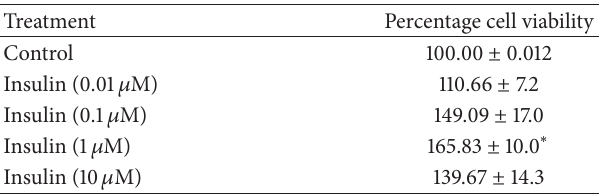
Table 3: Percentage of apoptotic cells in differentiated SH-SY5Y cells after treatment.